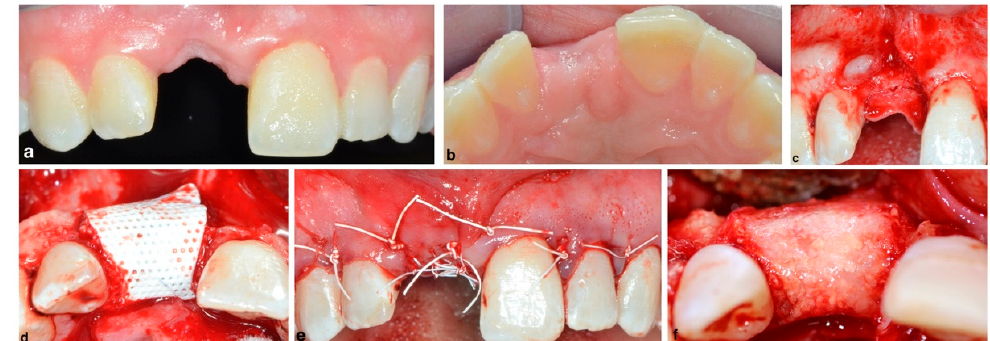
Figure 7. Vertical ridge augmentation with a dPTFE membrane and xenogeneic grafting material mixed with autologous bone chips simultaneous to implant placement: ( a ) pre-operative facial view of ridge deficiency in edentulous central incisor, ( b ) pre-operative incisal view of the ridge deficiency in edentulous central incisor, ( c ) soft tissue flap elevation revealing the vertical and horizontal ridge deficiency, ( d ) dPTFE non-resorbable membrane covering a mix of bone xenograft and autograft, ( e ) soft tissue flap covering the membrane and securing the flap approximation, and ( f ) 6-month post-operative ridge regeneration upon re-entry for implant placement.